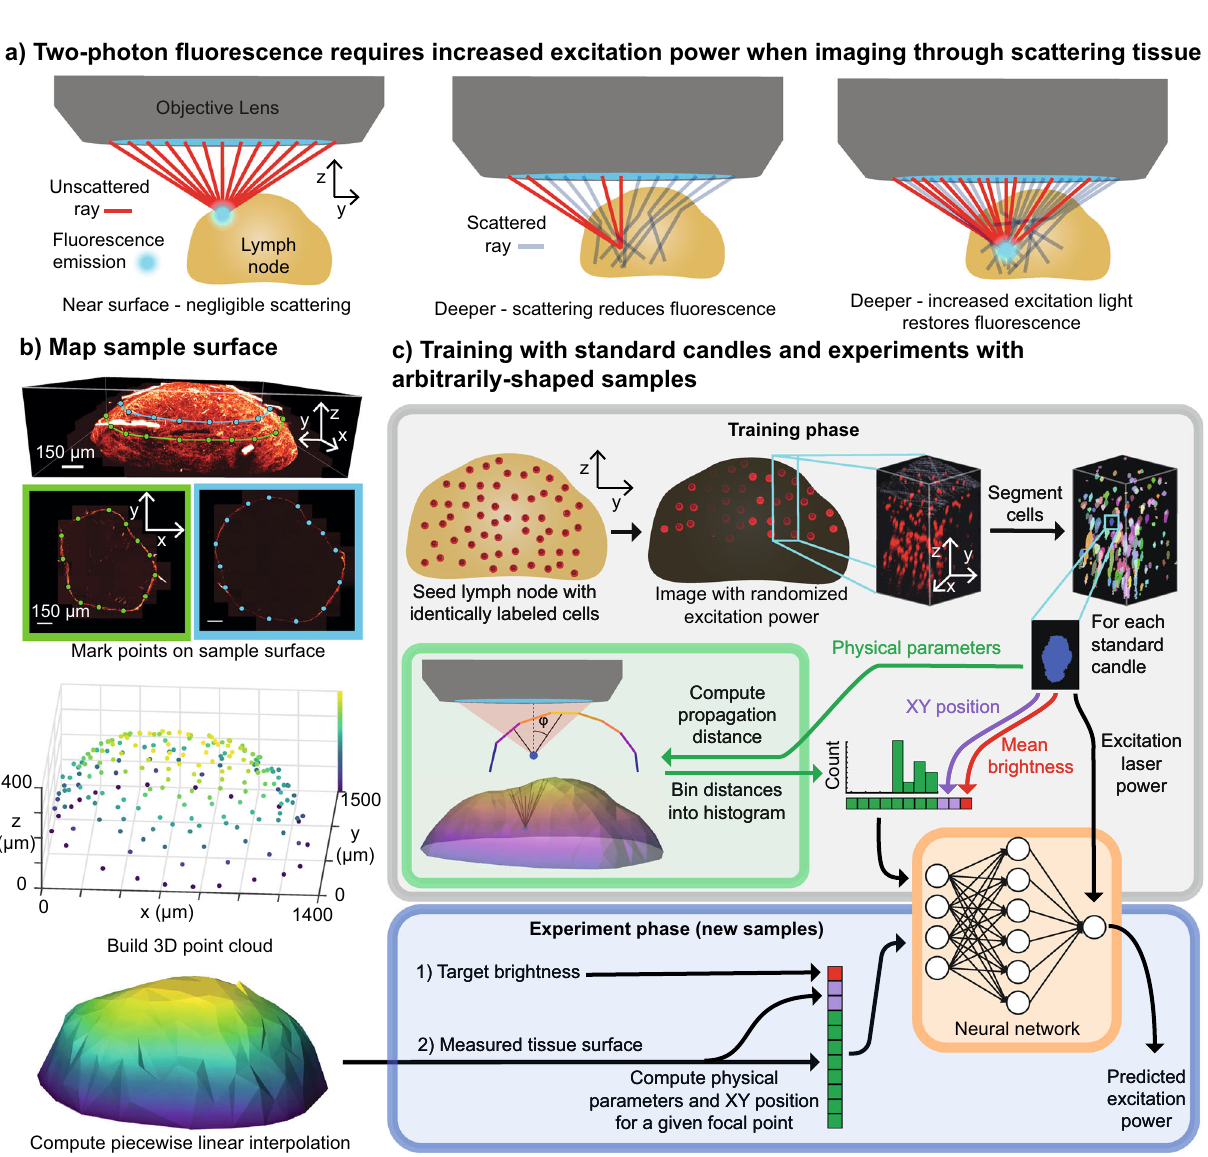
Fig. 1 Learned adaptive multiphoton illumination (LAMI). a In vivo multiphoton microscopy requires increasing laser power with depth to compensate for the loss of fl uorescence caused by excitation light being scattered. b Our LAMI method uses the 3D sample surface as input to its neural network. We map it by selecting points on XY image slices at different Z positions (top) to build up a 3D distribution of surface points (middle) that can be interpolated. c Training uses samples seeded with cells with the same fl uorescent label (standard candles), which is imaged with a random amount of power. A 3D segmentation algorithm then isolates the voxels corresponding to each standard candle. The mean brightness of these voxels, position in XY fi eld of view, and a set of physical parameters (a histogram of propagation distances through the tissue to the focal point at a speci fi c angle of inclination to the optical axis ( ϕ )) are concatenated into a single vector for each standard candle. The full set of these vectors is used to train a neural network that predicts excitation laser power. (Bottom) After training, subsequent samples need not be seeded with standard candles. The network automatically predicts point- wise excitation power as a function of the sample geometry and a user-speci fi ed target